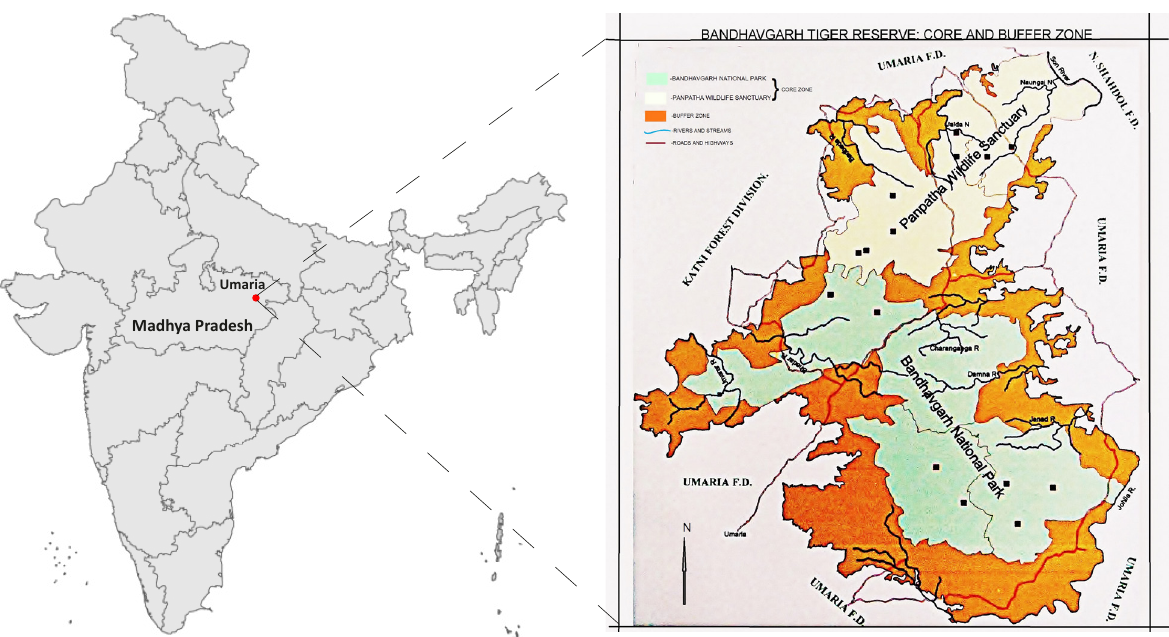
Figure 1. Location of Bandhavgarh Tiger Reserve in Umaria District of Madhya Pradesh, India